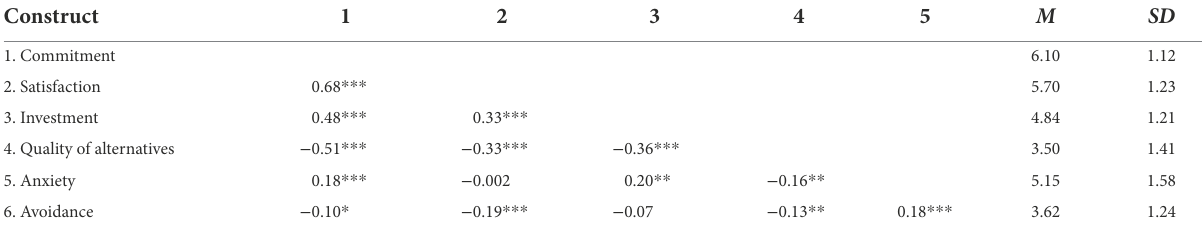
TABLE 1 Correlations between primary study